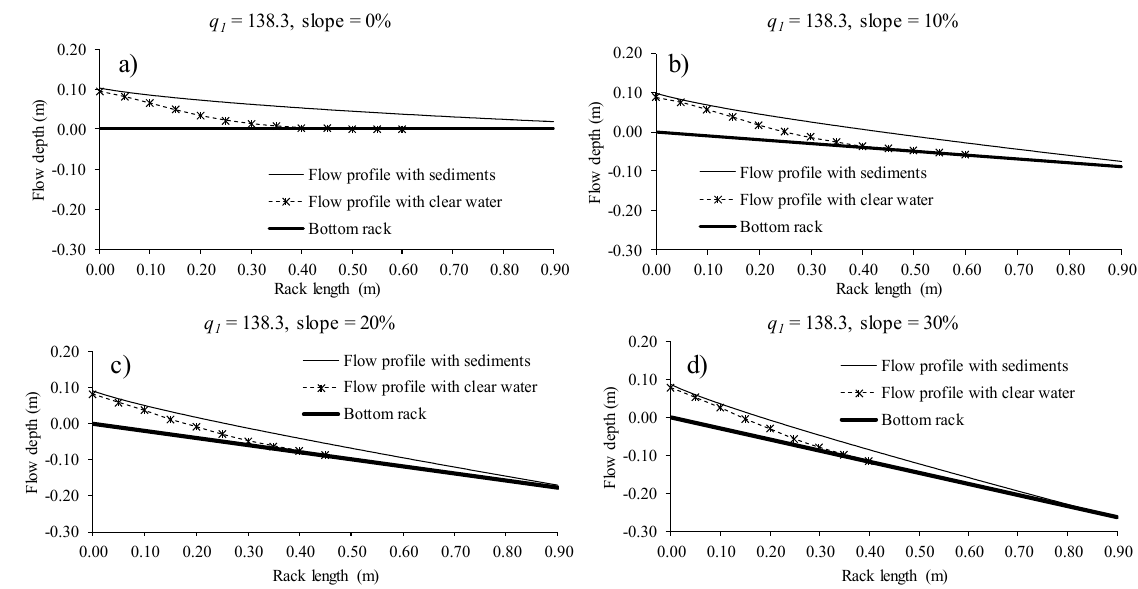
Figure 11. Water profiles over the rack measured in the laboratory and calculated for q 1 = 138.3 l/s/m and slopes ( a ) 0%; ( b ) 10%; ( c ) 20%; and ( d ) 30%.